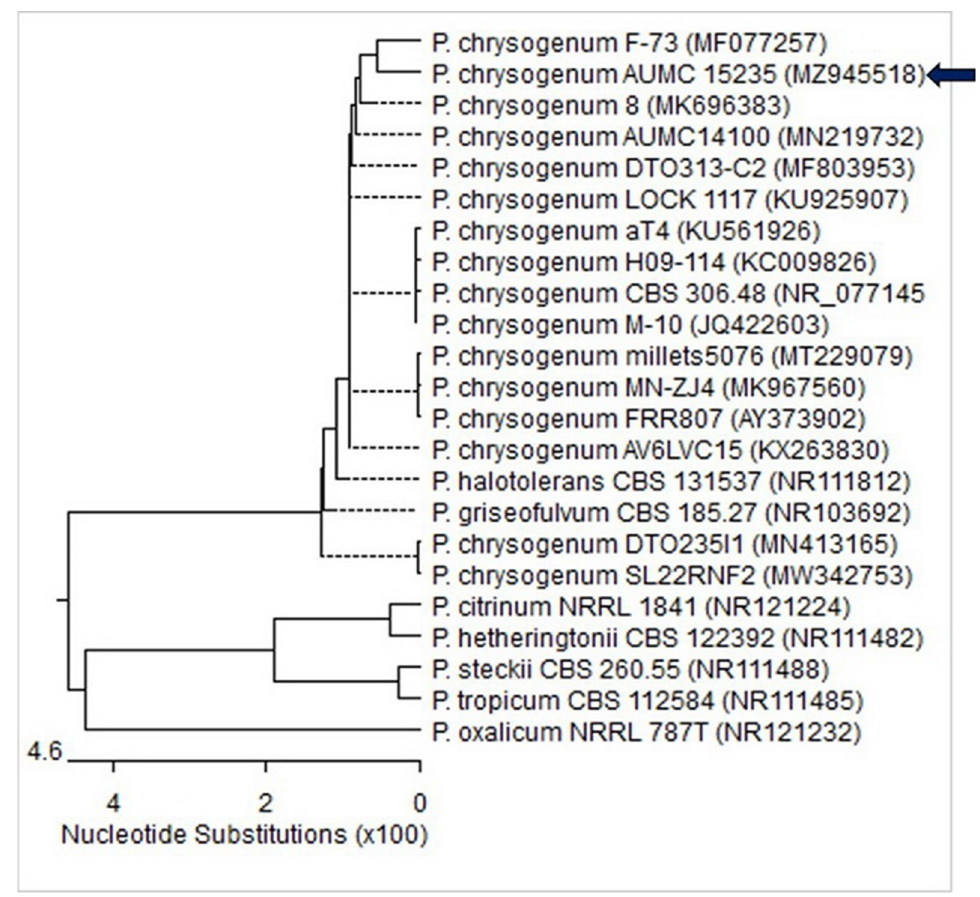
Figure 1. Phylogenetic tree of the fungal isolate depending on ITS sequence (GenBank accession no. MZ945518, arrowed) aligned with closely similar strains in the GenBank. ( P. = Penicillium ). The sequences were phylogenetically analyzed utilizing MegAlign (DNA Star) software version 5.05.